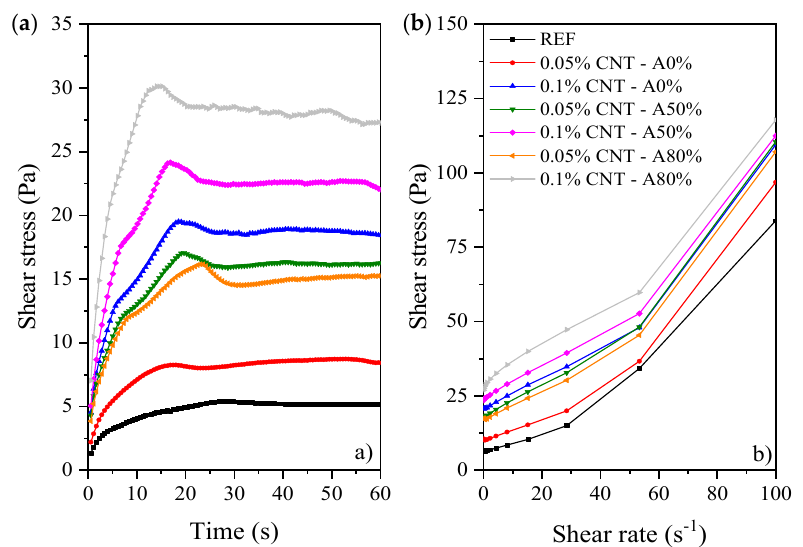
Figure 7. Curves of rheological tests: ( a ) static yield stress determination, and ( b ) flow curves of cement pastes.